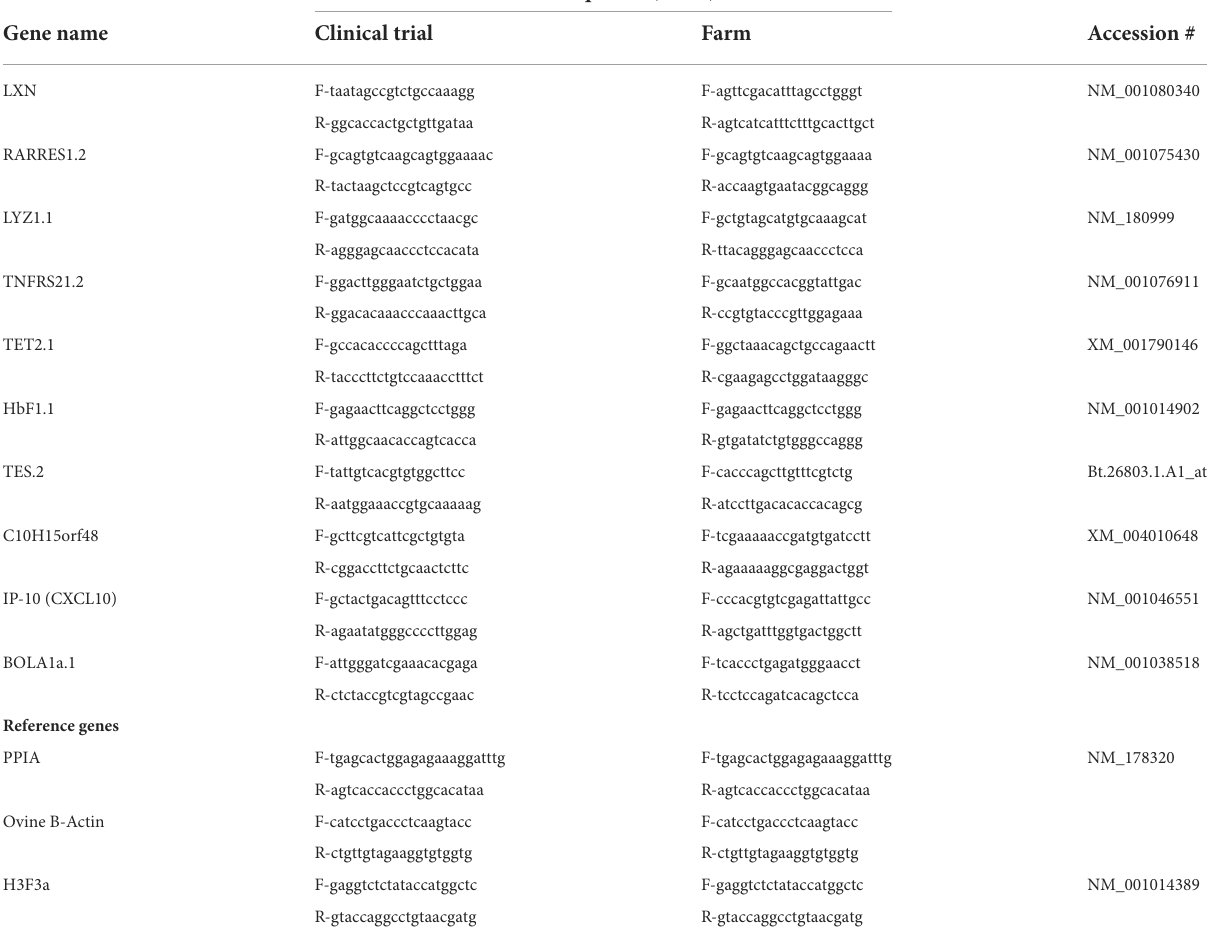
TABLE 2 Primer sequences for qPCR